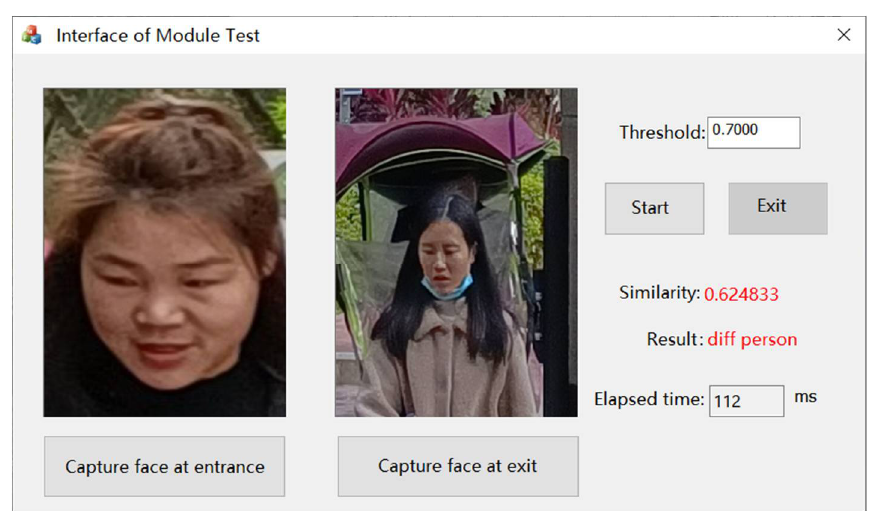
Figure 12. Test of different persons captured at the entrance and the exit.